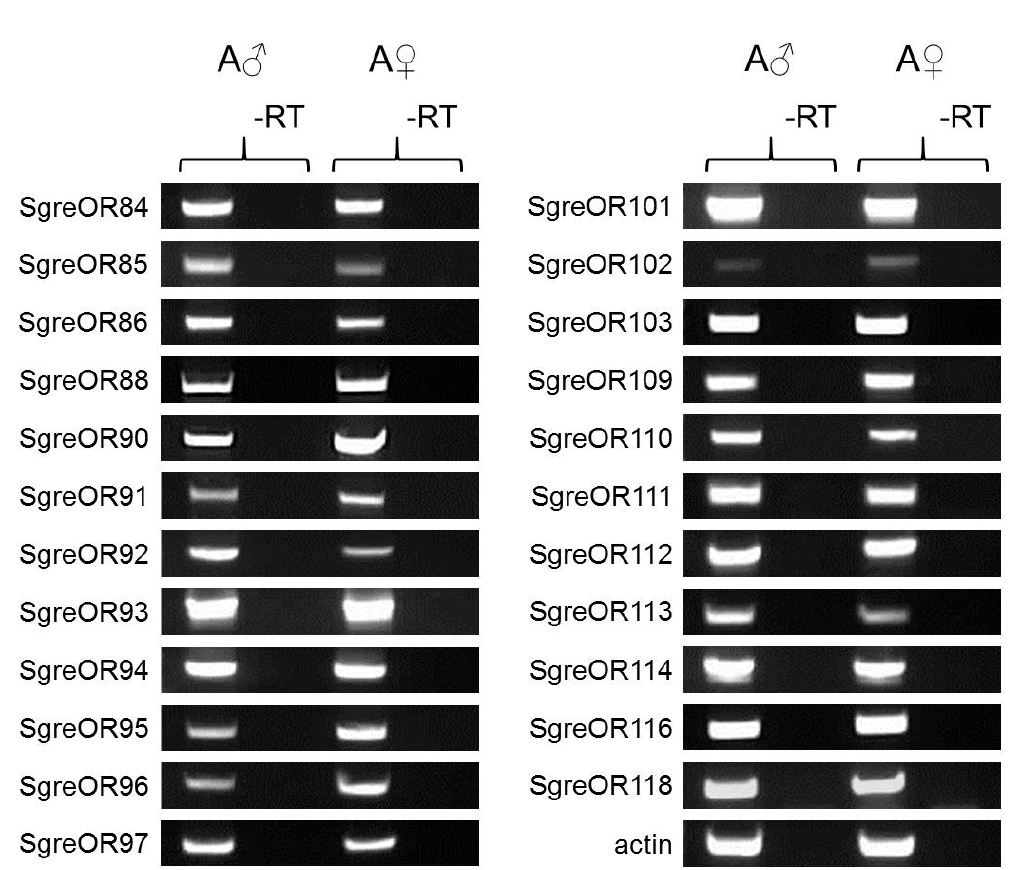
Figure 6. Analyses of a potentially sex-dependent expression of SgreORs of group II that are co-expressed with SNMP1. For 23 SgreOR types from group II that are co-expressed with SNMP1, expression in the antenna of male (A ♂ ) and female (A ♀ ) adult desert locusts was assessed by PCR experiments using receptor-specific primer pairs (listed in Table S2) and antennal cDNA. The resulting PCR products depicted have a predicted molecular size. Their identity was scrutinized by sequencing analyses, demonstrating that they encoded for the relevant SgreORs. In experiments with a negative control template (-RT), for which no reverse transcriptase was added to the cDNA synthesis reaction with antennal RNA, no amplicons of the expected molecular weight were observable.